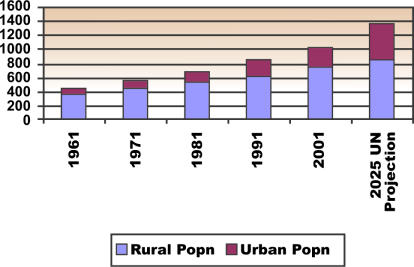
Magnitude of Urban Poverty Worldwide(Data sources: [14,15])The unit for the y axis is millions.Popn, population; UN, United Nations.